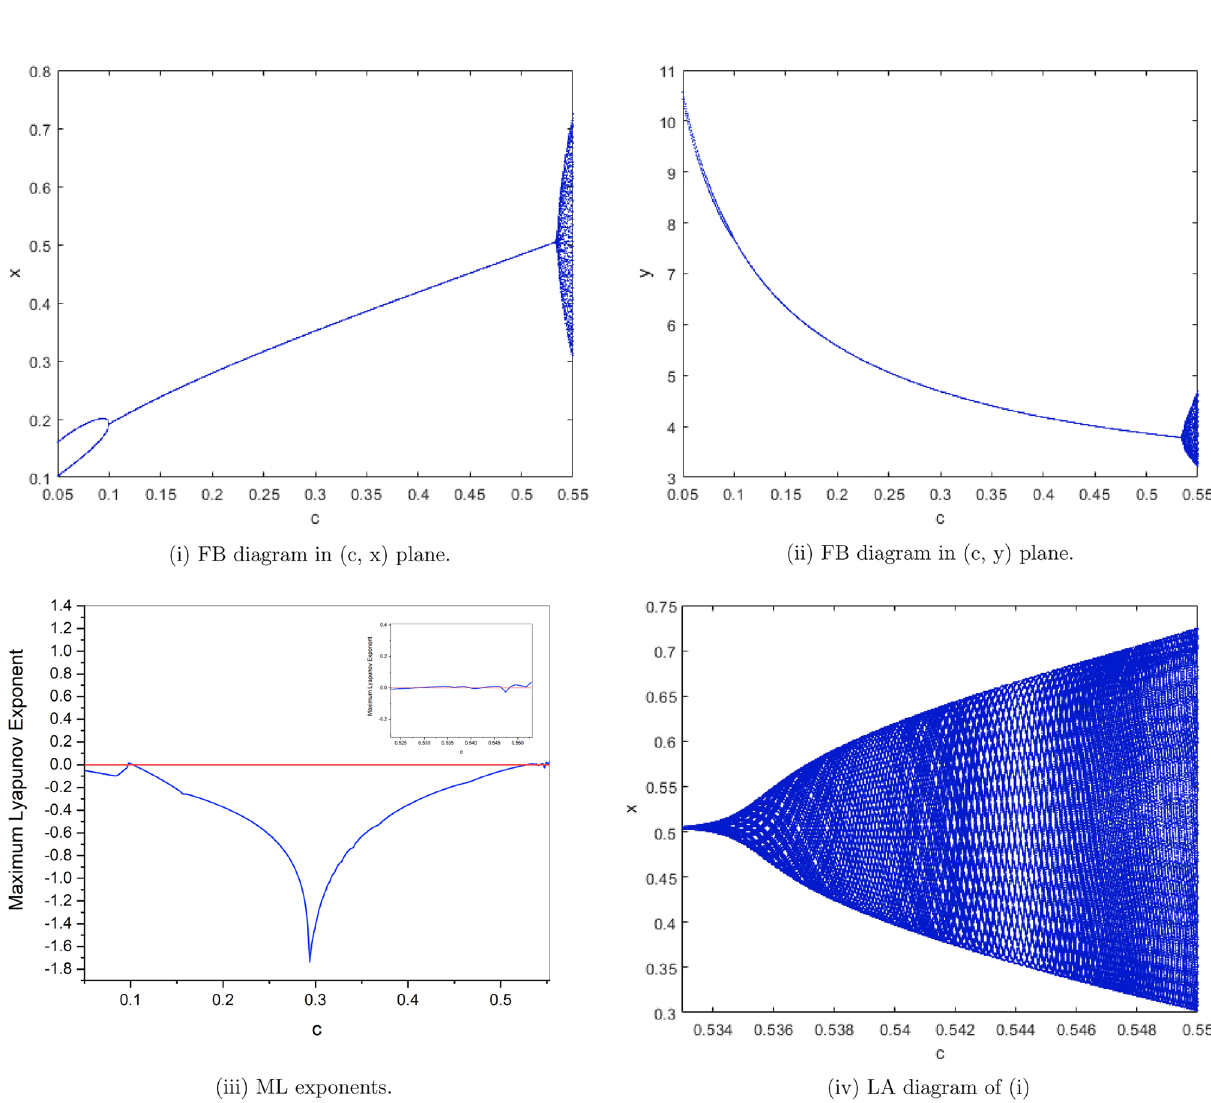
Figure 6. Bifurcation diagrams and ML exponents for the model (i) for values of a = 4, b = 2, e = 0.7, h = 0.5926274349, c ϵ [0.05, 0.5529] and LA corresponding to (i) for c ϵ [0.533,